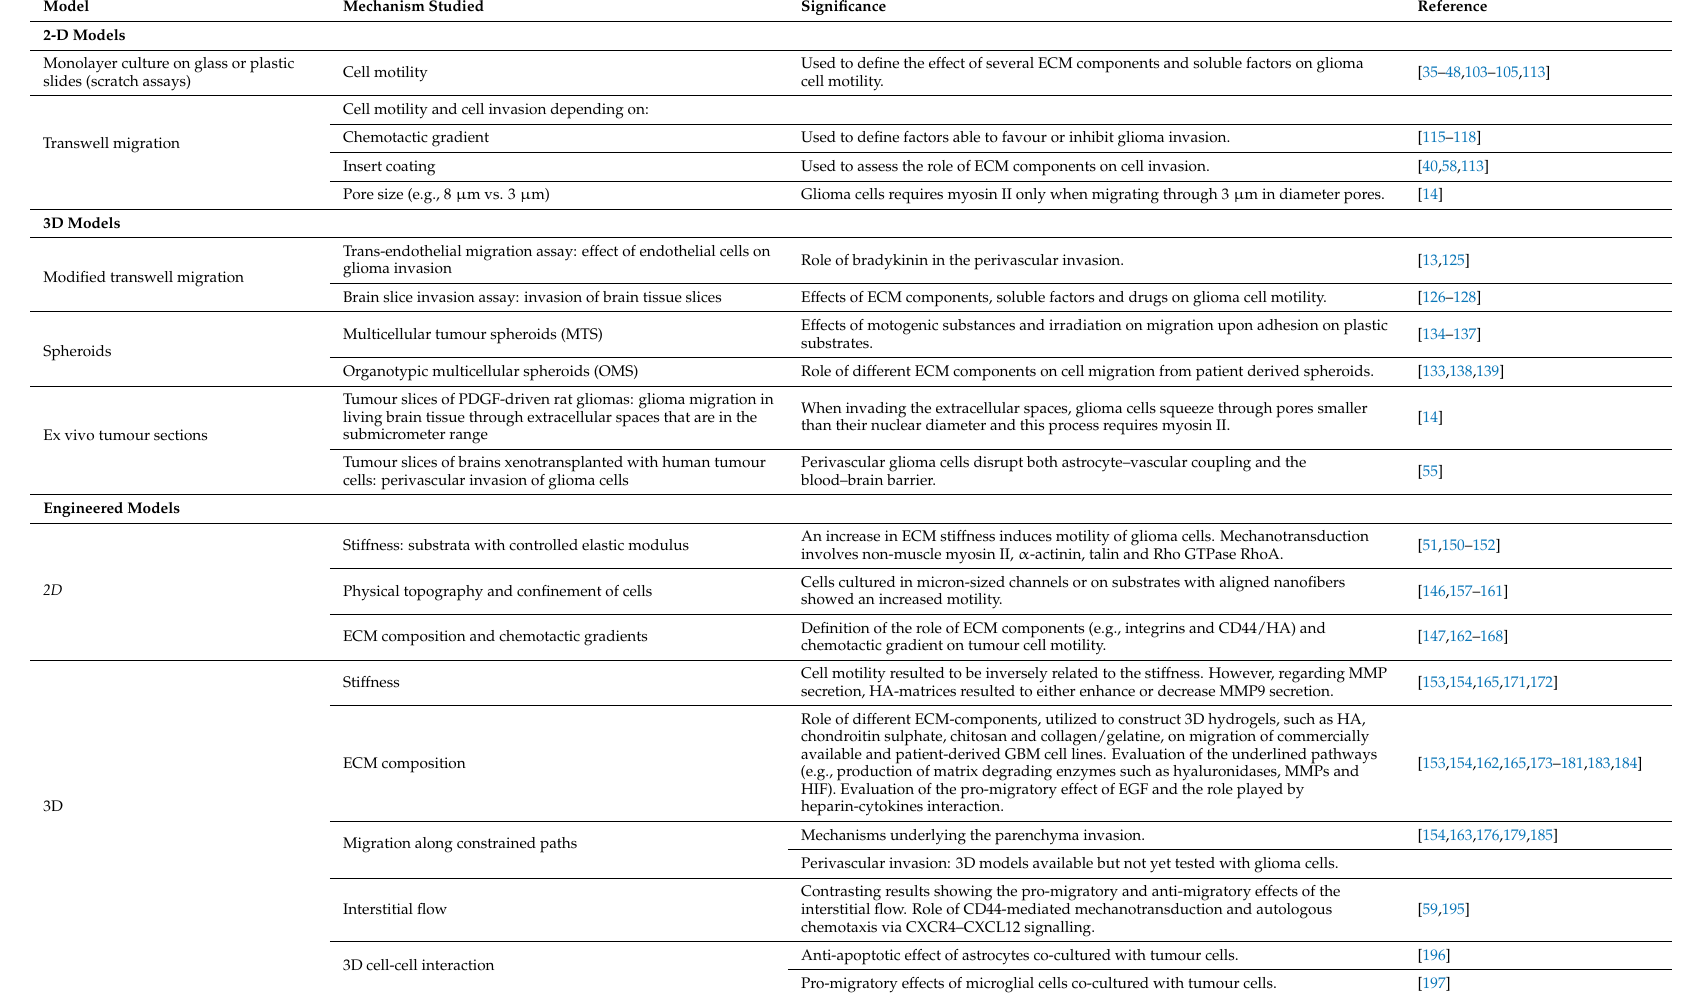
Table 1. Major results obtained by studying specific aspects of glioma invasion in 2D and 3D